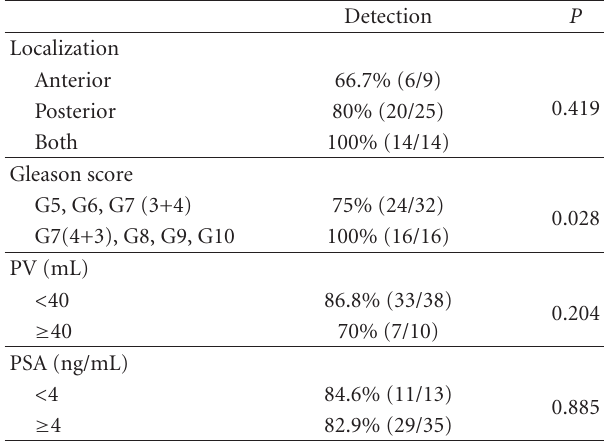
Table 1: Detection rate of all lesions ≥ 0.2cm 3 in dependence of localization, Gleason scores, prostate volumes and PSA serum values; n =